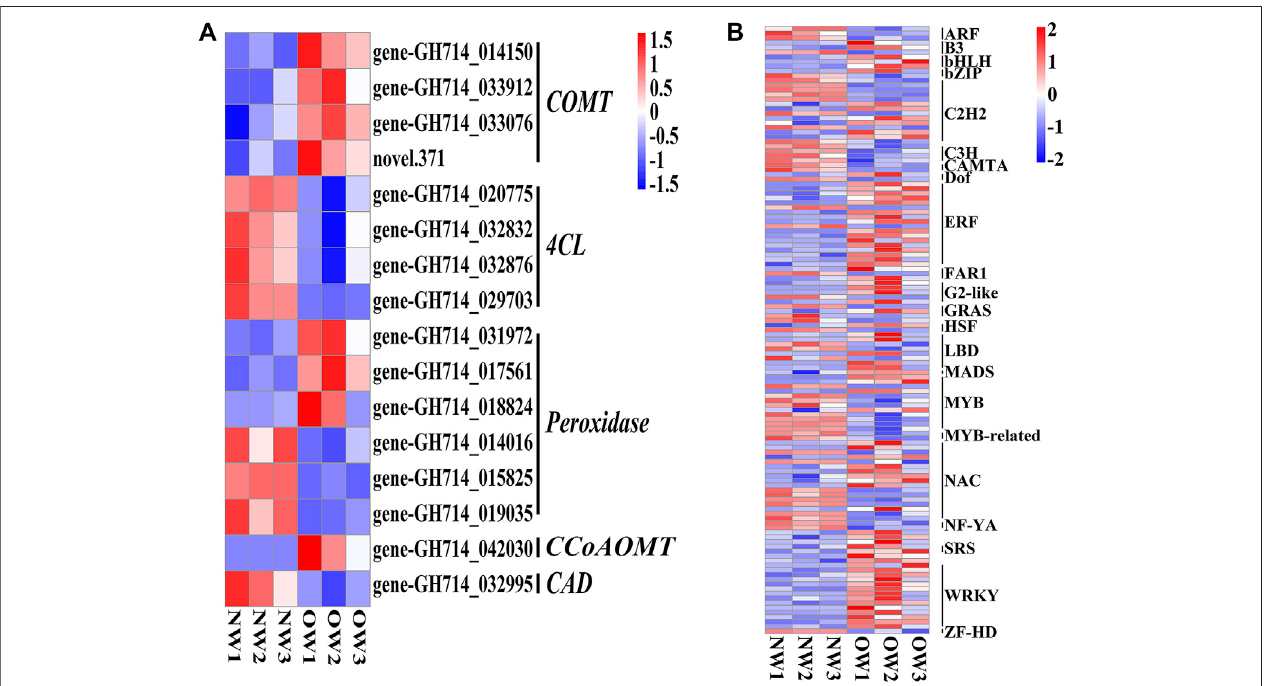
FIGURE 3 | Differentially expressed genes (DEGs) and transcription factors in OW vs. NW. Heatmap showing the expression of the DEGs (A) and transcription factors (B) identi fi ed in OW vs. NW. Columns represent three different samples per tissue type and rows represent different transcripts. Each square represents a transcript and the color indicates the level of expression; red represents up-regulation and blue represents